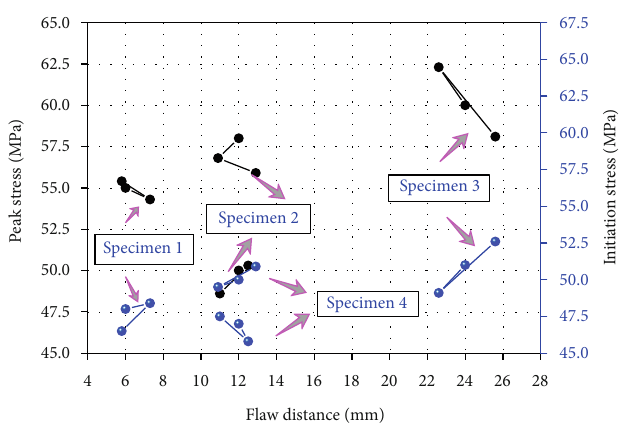
Figure 10: Curves of peak stress and initiation stress vary with fl aw distance of test specimens.